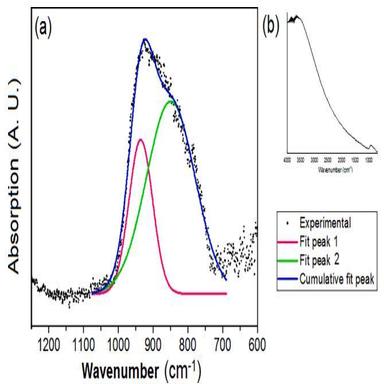
(a) FTIR-IRRAS spectra obtained at 30◦ for Nb2O5 thin film showing the highlighted region with bands centered at 849 and 935 cm− 1 and (b) the full range.